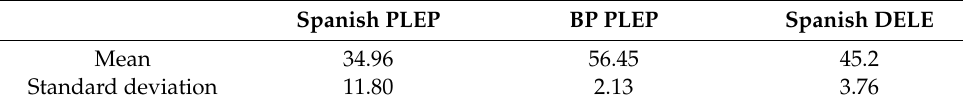
Table 2. Scores of the PLEP in Spanish and BP and Spanish